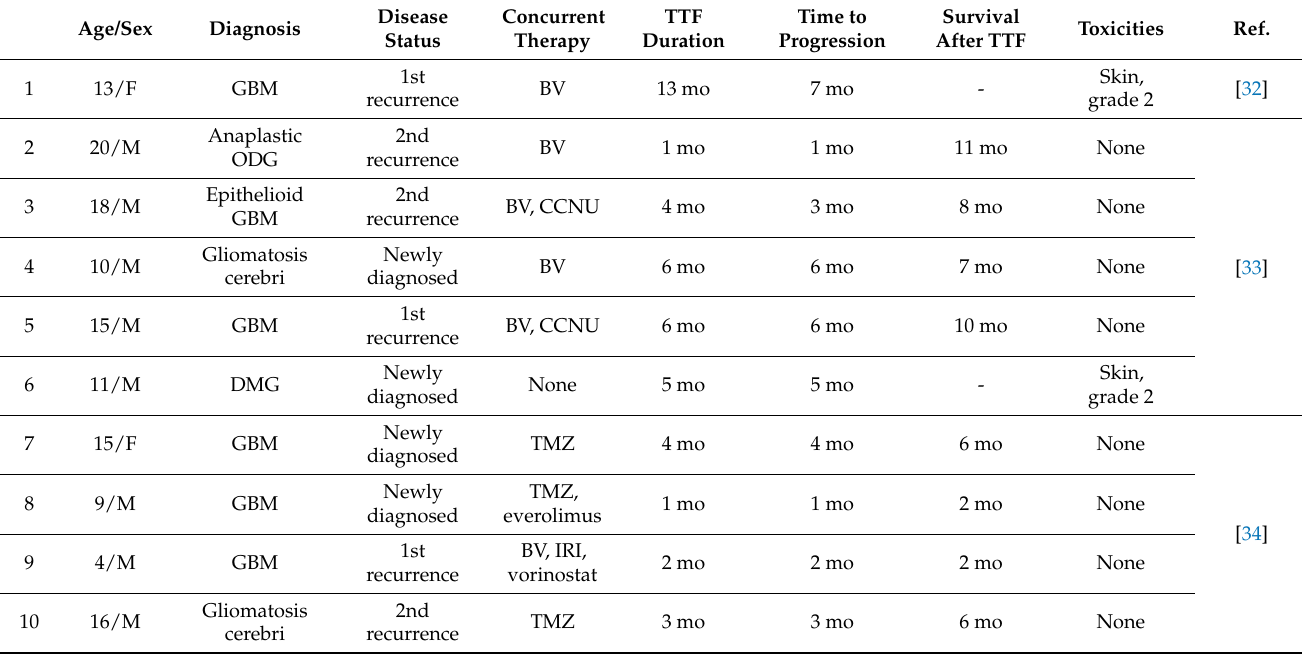
Table 2. Pediatric case description of TTFields